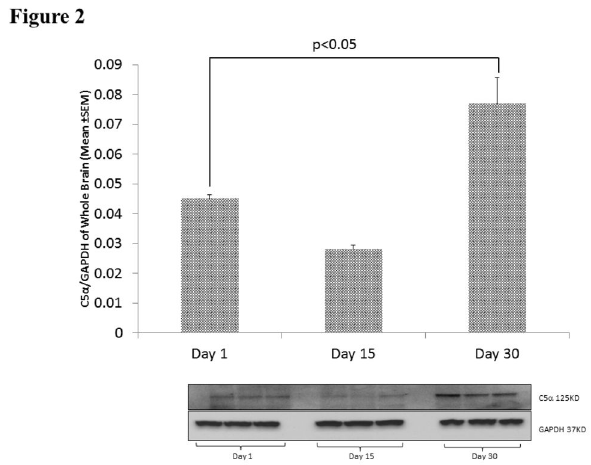
Figure 2. C5 deposition timeline by Western blot Analysis. C5α levels in BCAS mice at day 1 (n=3), 15 (n=3), and 30 (n=3). Bottom: Western Blots. Top: Relative C5α densities represented graphically (mean±SEM).